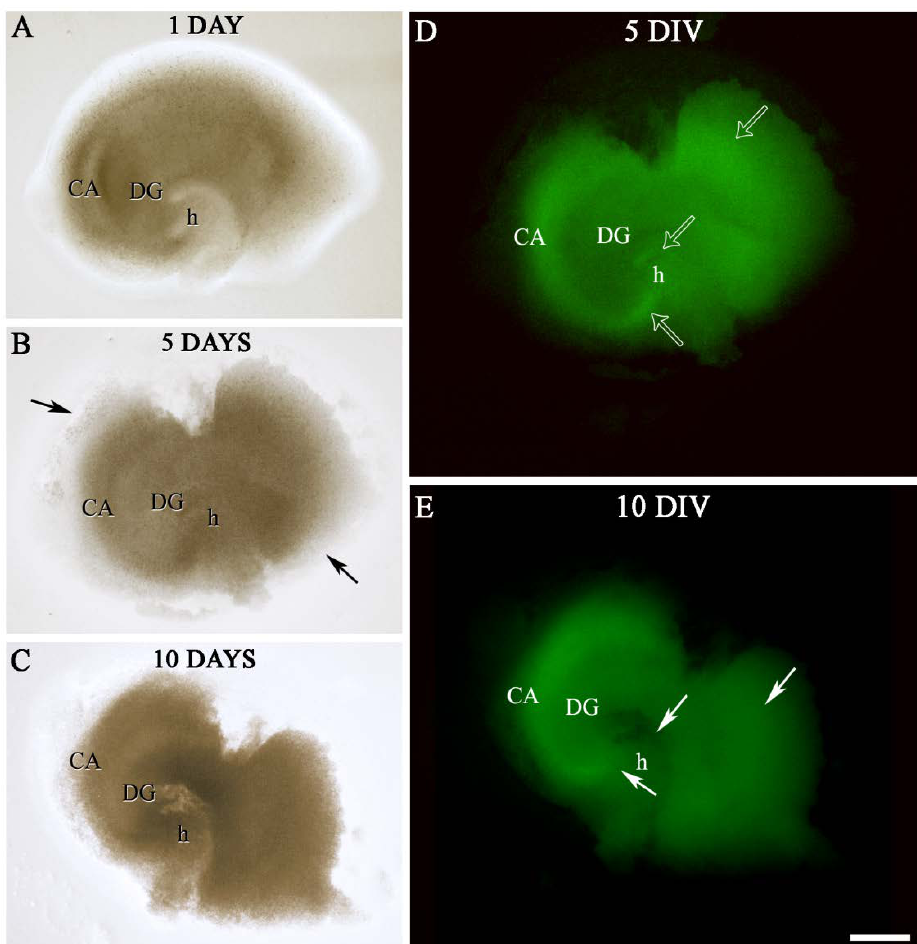
Figure 5. A representative septal section of P7 mice hippocampal formation in OHSC. Low-power photographs from a slice placed onto cell culture insert at 1 ( A ), 5 ( B , D ), and 10 DIV ( C , E ). ( A – C ) displayed a progressive shrinkage of section thickness (black solid arrows) from 1 DIV ( A ) to 10 DIV ( C ) lower than chip slices ( B ) (see also Figure 3). ( D , E ) showed the same general pattern of distribution of OGB labeling throughout the hippocampal subregions up to 10 DIV observed in the organ-on-a-chip. Note the changes in the OGB labeling distribution between 5 and 10 DIV. At 5 DIV (medium phase) a dense dot-shaped labeling was observed through whole hippocampal formation (open arrows) ( D ). By contrast, at 10 DIV there was a sharp decrease labeling with partial or total lack of OGB labeled cells (solid arrows) in some zones of hippocampal formation (late phase) ( D – E ). CA, cornu Ammonis subfield; DG, dentate gyrus; DIV, days in vitro; h, hilus. Scale bar shown in E indicates 510 µm in ( A – C ) and 480 µm in ( D , E ).